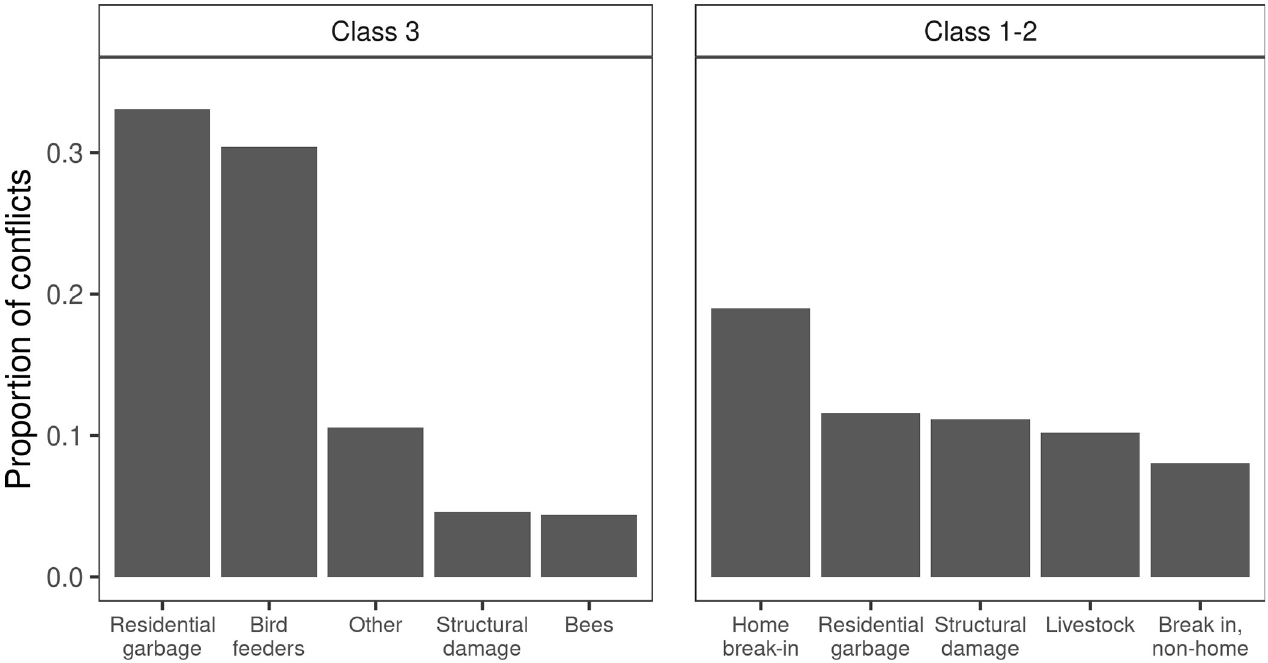
Fig 2. Proportions of the five most common types of reported human-black bear conflicts across 68 Wildlife Management Units, New York, USA, 2006– 2019.